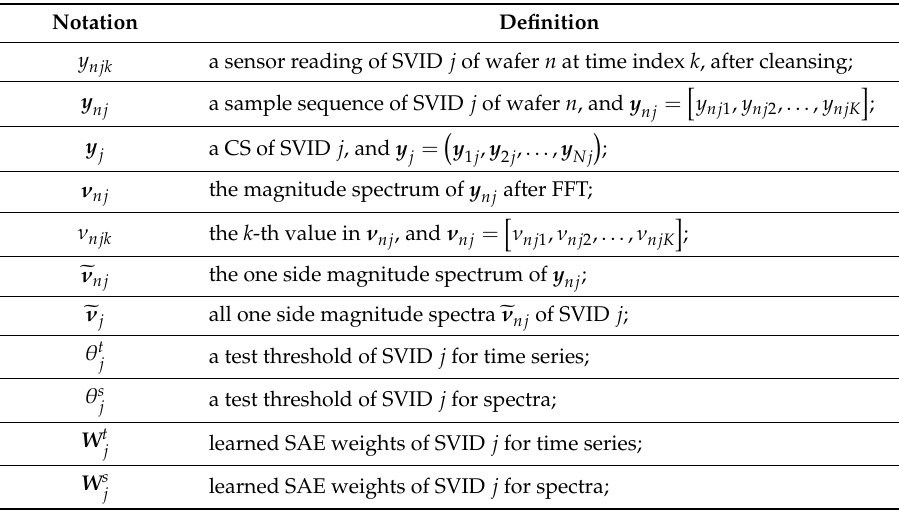
Table 4. Notations that are expressed by